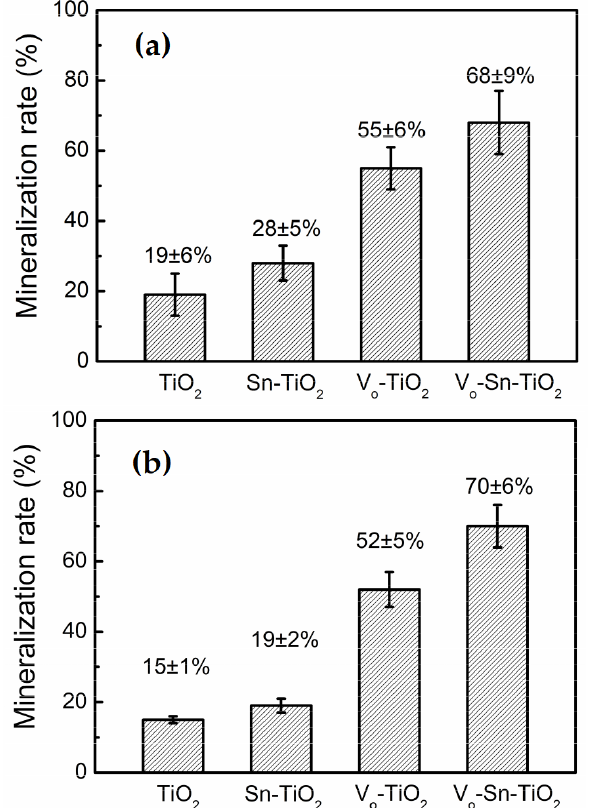
Figure 4. ( a ) Rates of nitrobenzene photocatalytic mineralization by visible-light-exposed TiO 2 , Sn- 347 TiO 2 , Vo-TiO 2 , and Vo-Sn-TiO 2 . ( b ) Rates of RhB photocatalytic mineralization when exposed to 348 TiO 2 , Sn-TiO 2 , Vo-TiO 2 , and Vo-Sn-TiO 2 . Ref. [48] is reprinted with permission. 2016 Elsevier B.V. 349